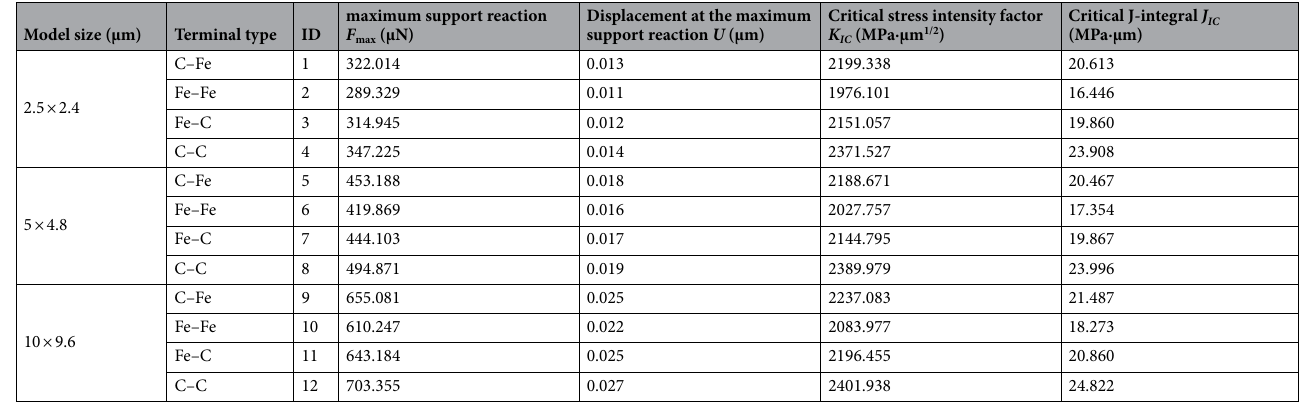
Table 12. Fracture toughness results calculated by finite element method of different models at micro scale.